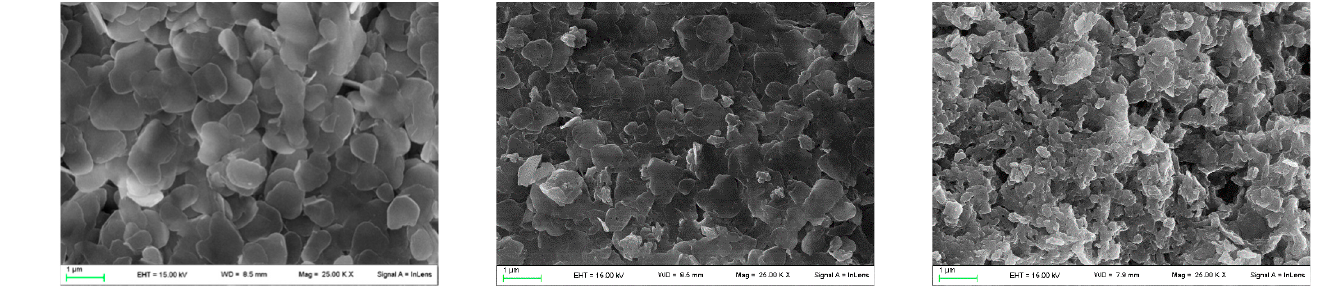
Figure 5. From the left: SEM images of pristine α ZP, α ZP05, and α ZP1. In both series, the EDX analysis shows a homogeneous distribution of nitrogen, carbon, phosphorus, and zirconium elements, thus, attesting that the topotactic exchange occurred successfully in both cases. The signal of the sodium element was also detected by EDX, confirming that it is included in the structure to some extent (Figures S3 and S4). 31